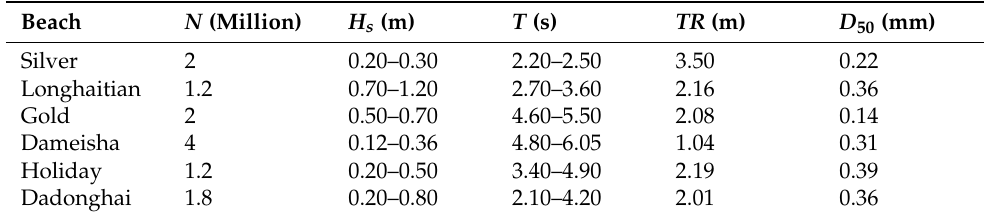
Table 1. Visitor volume and hydrological conditions of beaches. N stands for yearly visitor reception, H s for the average significant wave height, T for the average significant wave period, TR for annual average spring tidal range, and D 50 for median sediment